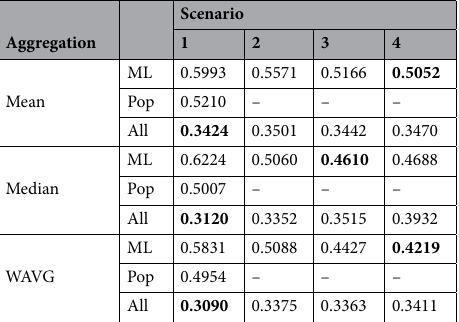
Table 4. MAPE obtained in each scenario according to each form of aggregation, for the Spain case in the test split. Lowest error values are in [bold].